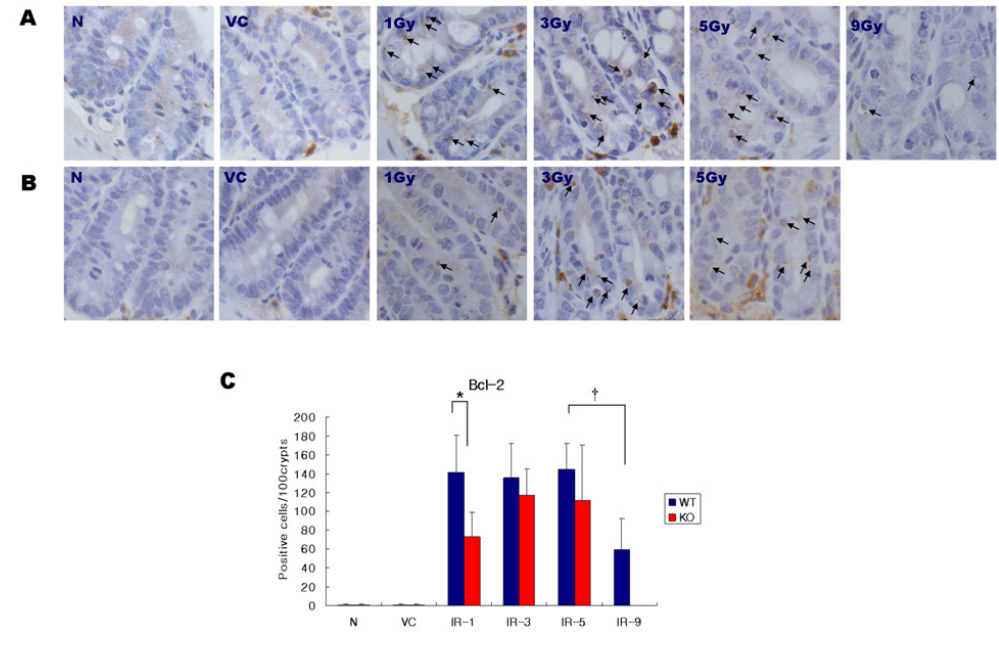
Figure 4. Bcl-2 expression detected by immunohistochemistry in the crypts of the intestine in WT mice ( A ) and SMP30 KO mice ( B ). N, normal control; VC, vitamin C; Gy, Gray. Original magnification × 1000, Bars = 20 μ m. ( C ) Positive cells were quantified from the immunohistochemically stained sections with Bcl2. Values represent the mean ± SD in each group. WT, wild type; KO, knock out; * and †, Statistically significant